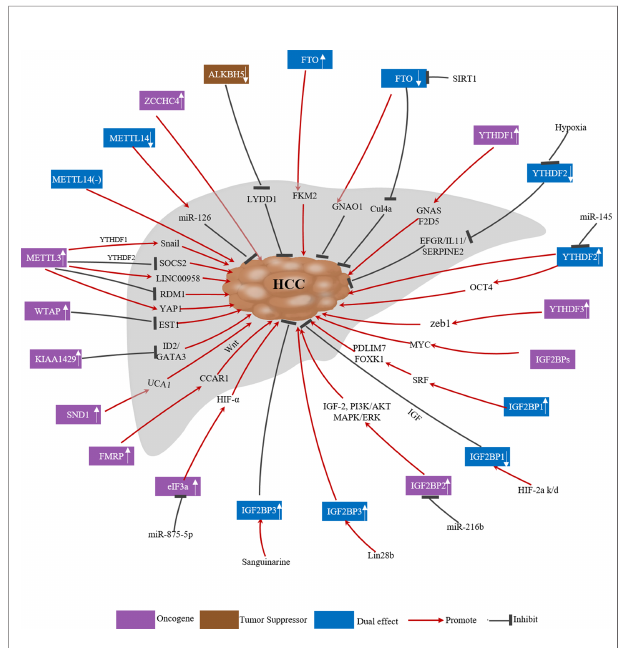
FIGURE 2 | Deregulation of m6A related regulators in human